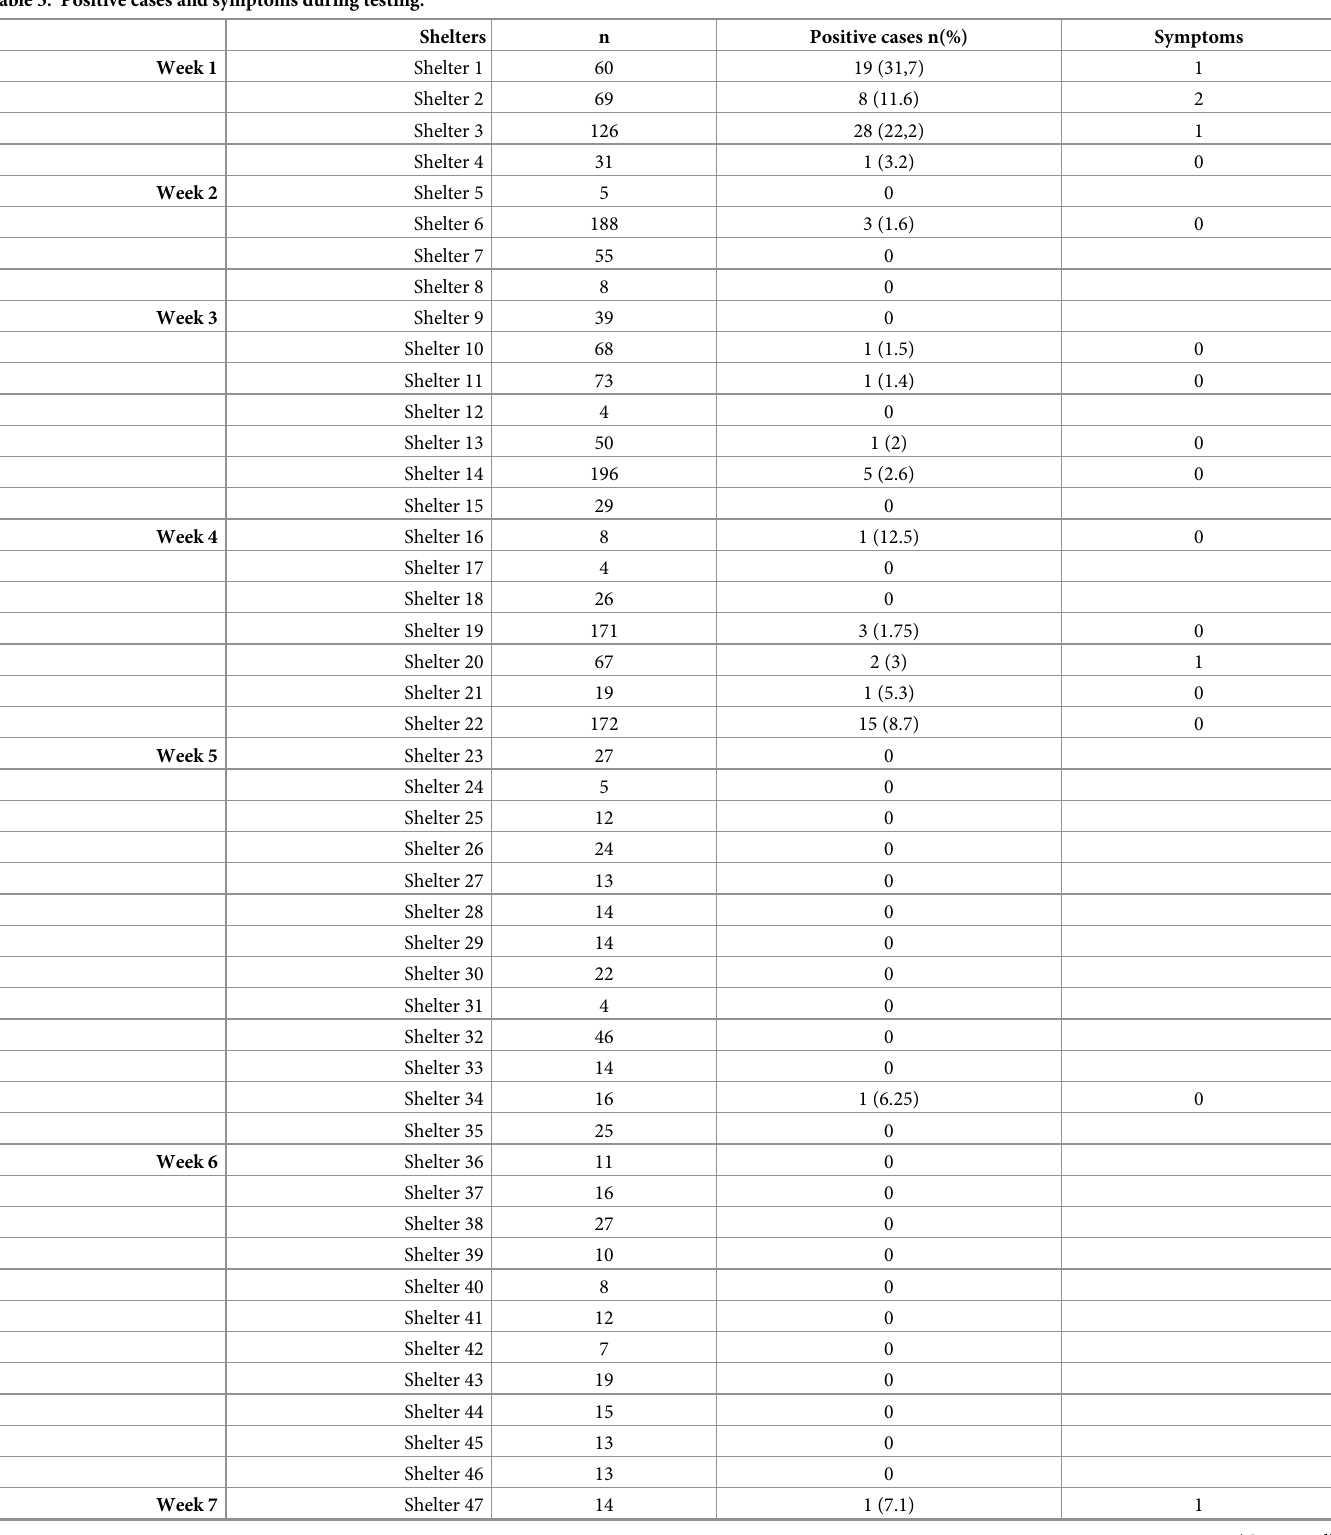
Table 3. Positive cases and symptoms during